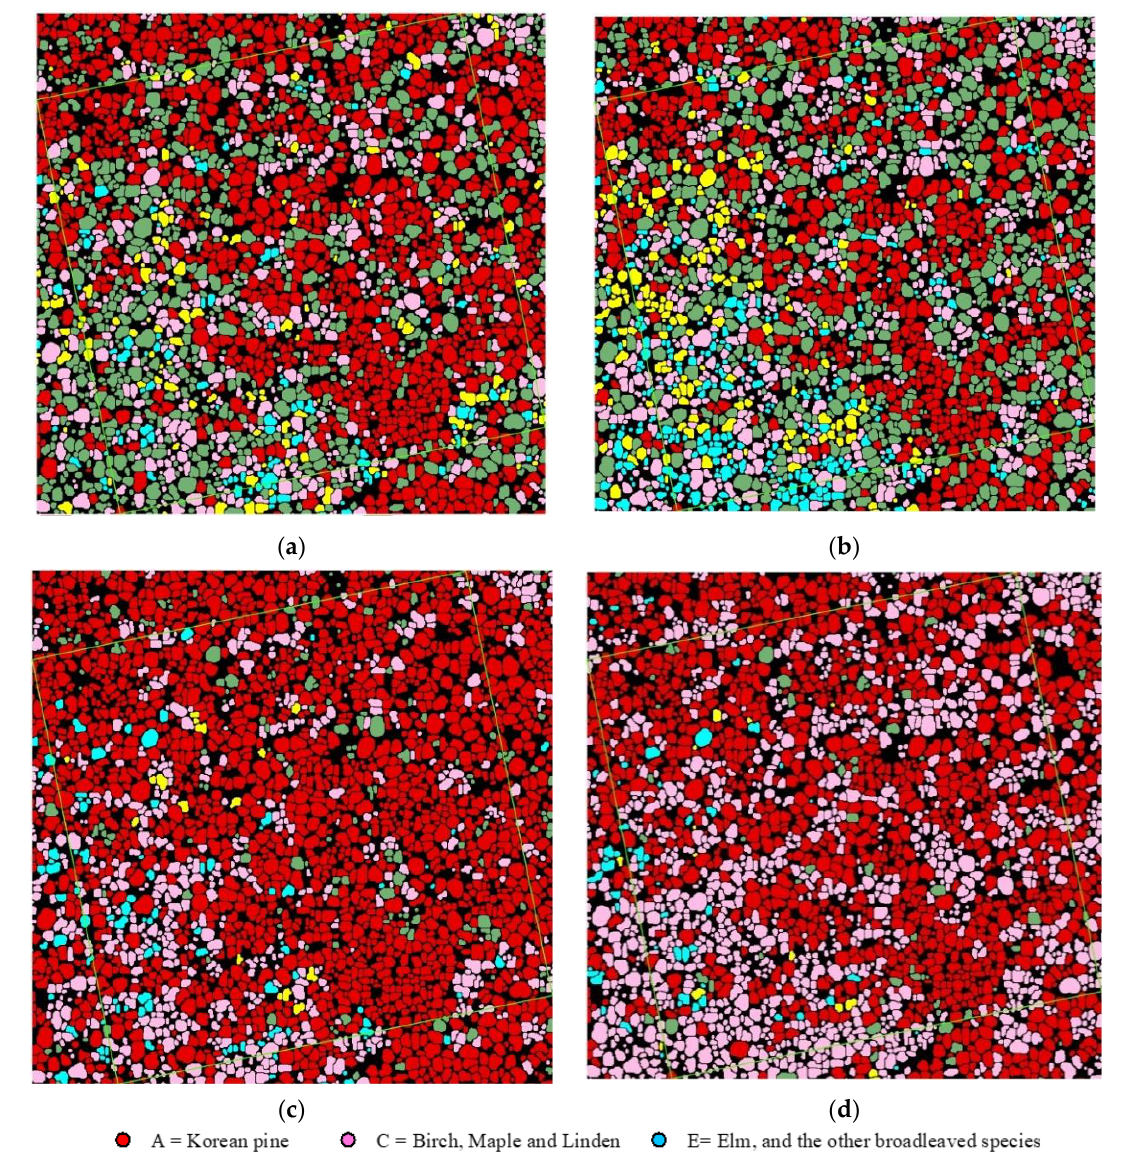
Figure 10. Classification results of crown-based ITC and pixel-based ITC: ( a ) result of crown-based ITC-SVM; ( b ) result of crown-based ITC-SAM; ( c ) result of pixel-based ITC-SVM; ( d ) result of pixel-based ITC-SAM.